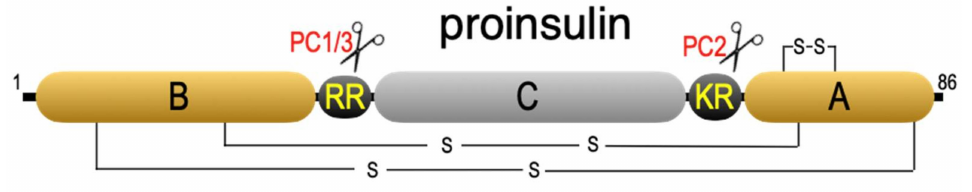
Figure 1. Proinsulin. Shown are the disulfide bonds and the sites cleaved by PC3 (PC1/3) and